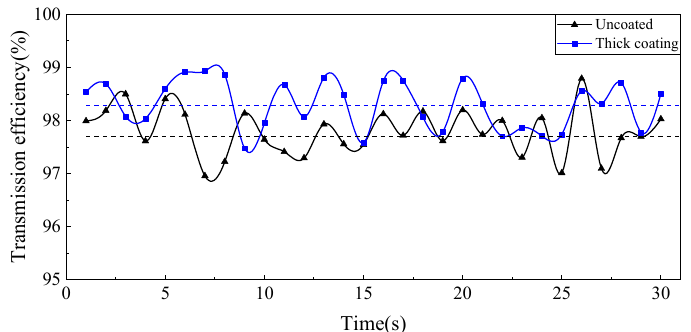
Figure 7. Comparison of gear transmission efficiency.